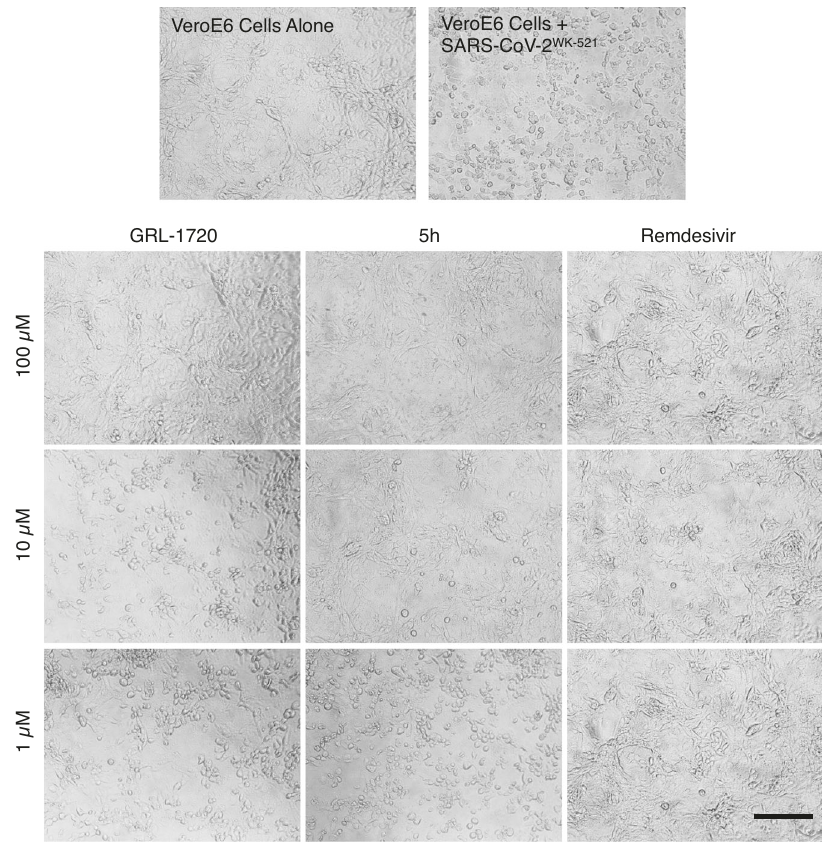
Fig. 3 GRL-1720 and 5h exert potent activity against SARS-CoV-2 WK-521 . VeroE6 cells were exposed to SARS-CoV-2 WK-521 for 1 h, the virus was washed off, and the cells were cultured in the presence of various concentrations of test compound for 3 days. The images shown are those captured under light microscopy. VeroE6 cells cultured alone (top left) appear to be robust; however, those exposed to SARS-CoV-2 WK-521 and cultured in the absence of test compounds, a number of cells were destroyed by the cytopathicity of the virus and appear granular (top right). VeroE6 cells exposed to the virus and cultured with each of the two compounds, GRL-1720 and 5h (at 1, 10 and 100 µ M). The virus-exposed cells cultured with 100 µ M, all the cells appeared to be completely protected. Representative images from three independent experiments are shown. Scale bar = 200 µ